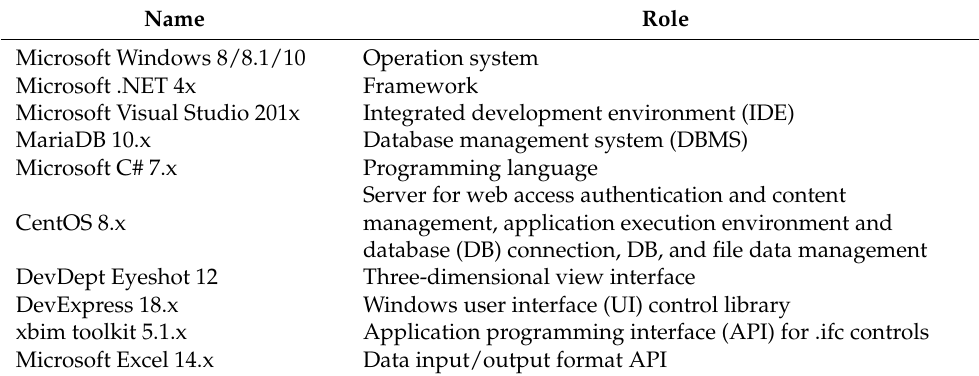
Table 1. Development environment and components.